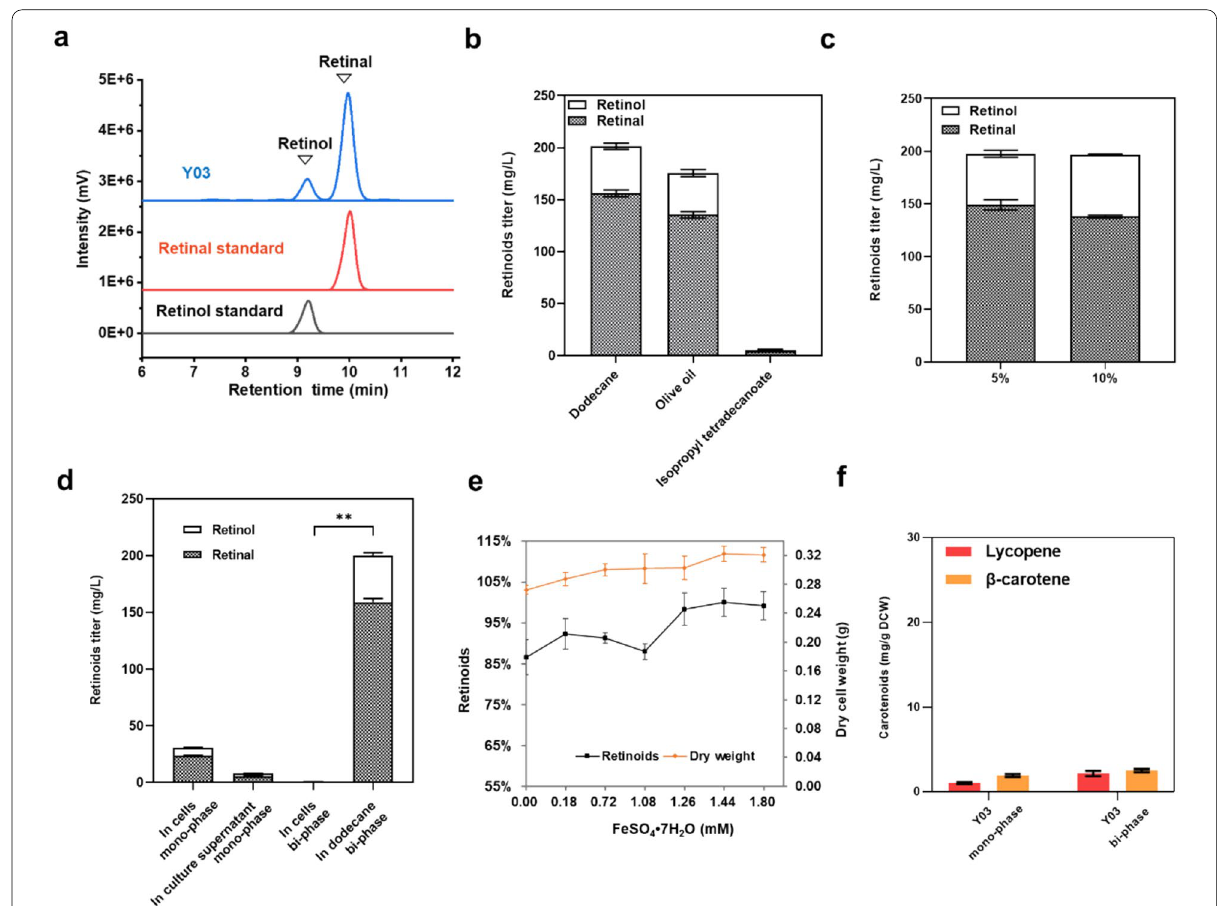
Fig. 2 Retinoids biosynthesis in the engineered yeast strain Y03. a HPLC chromatograms of strain Y03, together with the retinal and retinol standards. b Effect of extractant type on bi-phasic fermentation of retinoids. c Effect of dodecane overlay volume on retinoids production. d Distribution of retinoids in mono- and bi-phasic fermentation. e Effect of Fe 2 + addition on retinoids production. f Intracellular accumulation